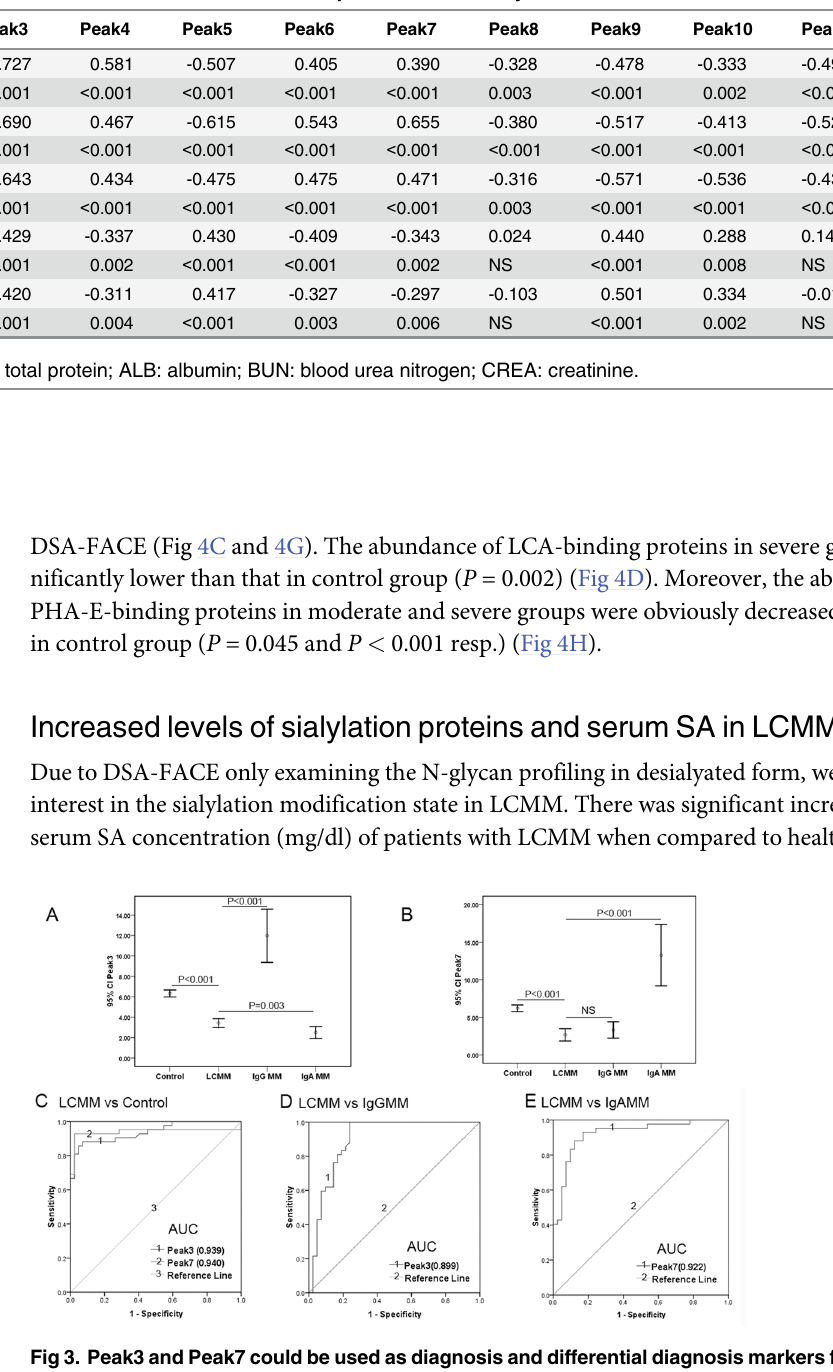
Table 3. Correlation between N-glycan markers and clinical indexes in LCMM patients and healthy controls. Correlations